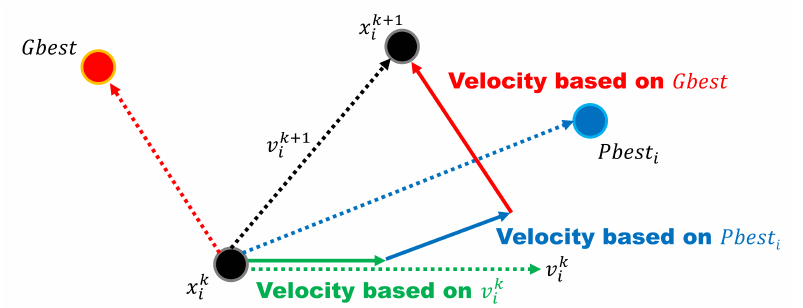
Figure 4. A conceptual searching scheme of particles in a particle swarm